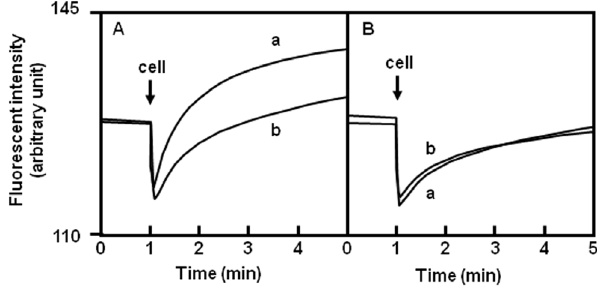
Figure 4. Acriflavine efflux from cells elicited by an inwardly directed artificial Na + gradient. An inwardly directed chemical gradient of Na + was imposed by the addition of the cell suspension into the assay medium containing salt at the time point indicated by the arrow. (A) E. coli KAM32/pHAP5, (B) E. coli KAM32/pHY300PLK. The final concentration of the salt was 100 mM NaCl (curve a) or 100 mM KCl (curve b). The assay was performed at 37 u C.